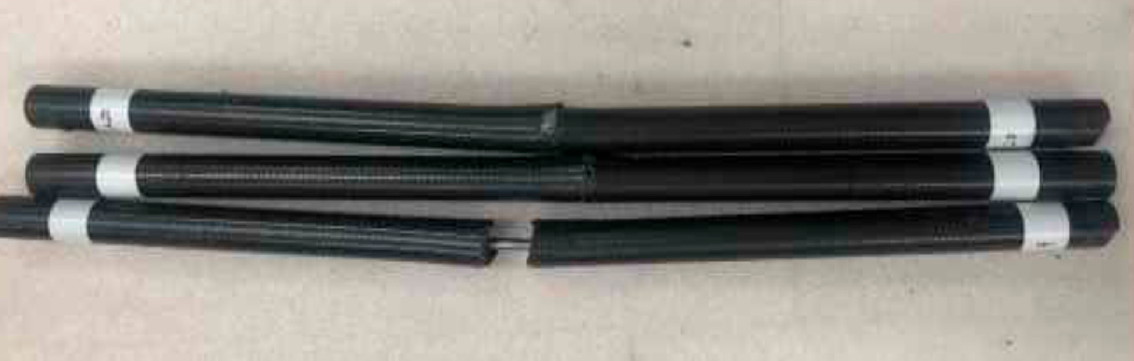
Figure 8. Failure modes of steel and hybrid rods after testing.